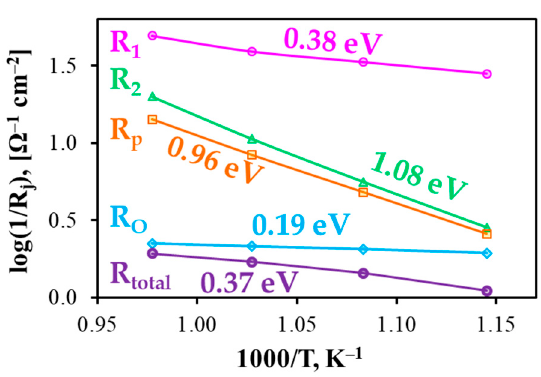
Figure A1. Temperature dependences of constitute resistances (R j ) of the fabricated PCC in Arrhenius coordinates. The corresponding activation energies calculated in Frenkel coordinates (log(T/R j ) = ƒ(1/T)) are also presented.